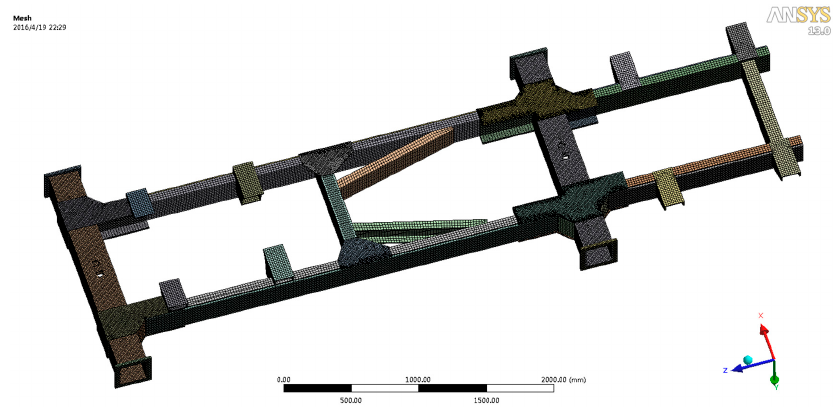
Figure 8. Frame model meshing.